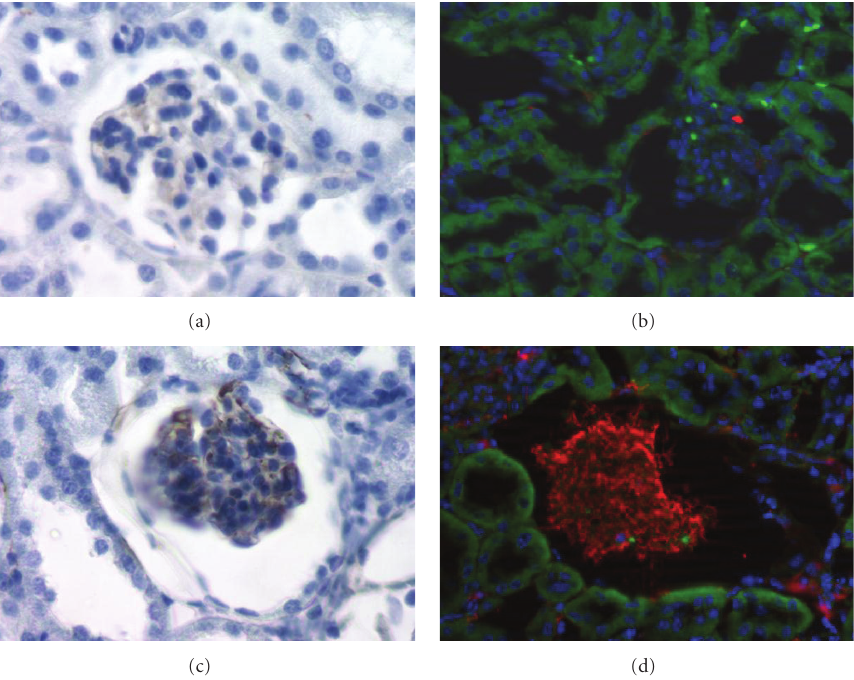
Figure 1: Fibrin accumulation in both AnxA 2 − / − and hyperhomocysteinemic mice. Kidney sections from AnxA 2 + / + mice on normal chow (a and b), from AnxA 2 − / − mice on normal chow (c), or from AnxA 2 + / + mice on a high methionine diet (d). Sections from heparin- treated, highly perfused animals were stained with a polyclonal rabbit antifibrin(ogen)-specific antibody using either immunoperoxidase plus diaminobenzidine (brown immunoreaction product) with hematoxylin counterstaining [5] (a and c), or biotinylated goat anti-rabbit IgG followed by Alexa 568-conjugated streptavidin (b and d); red staining represents Alexa 568, blue represents DAPI nuclear staining, and green is tissue autofluorescence